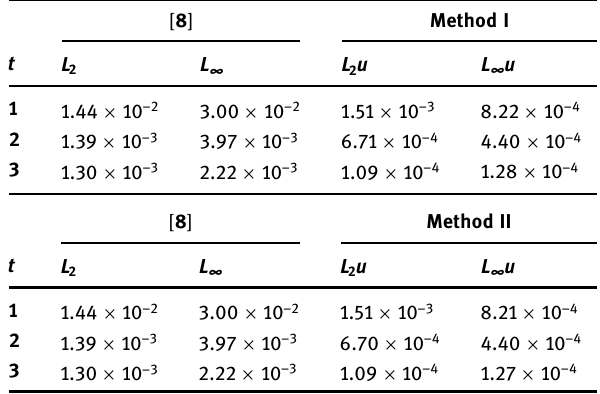
Table 23: Comparison of errors for = N 11 ,